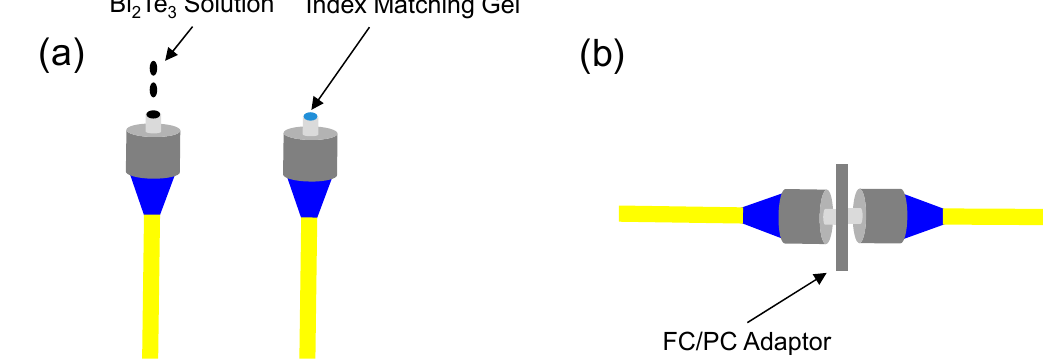
Figure 3. ( a ) The prepared fiber ferrules. ( b ) The connecting schematic diagram of the Bi 2 Te 3 SA.